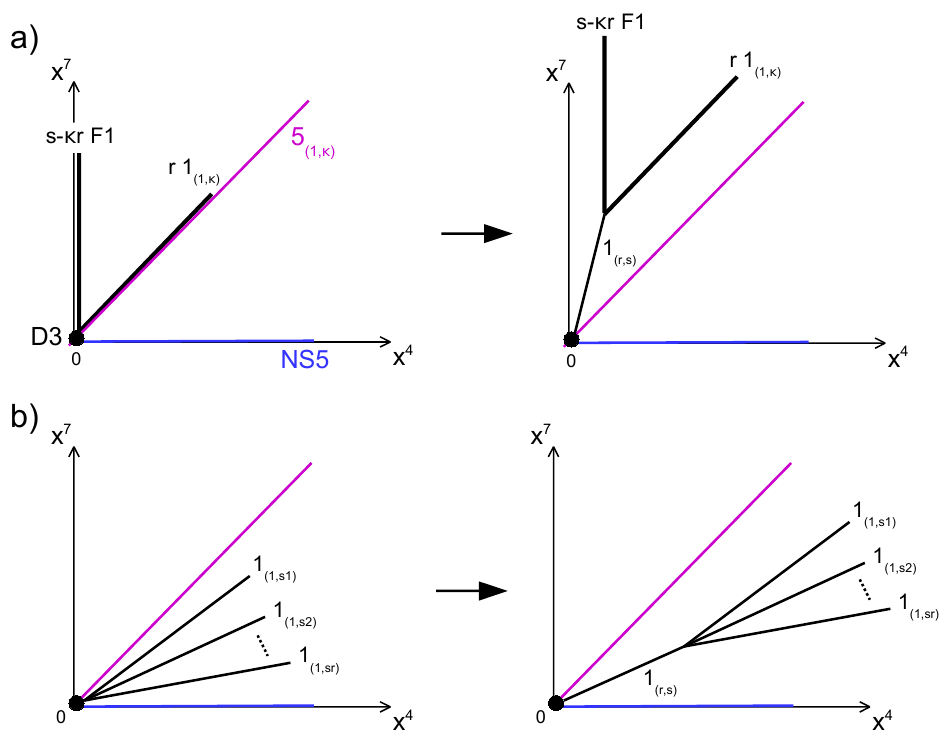
strings can be deformed into a (1 ;(cid:20) ) strings, (1 ;s i ) string ending on the D3, ( r;s )